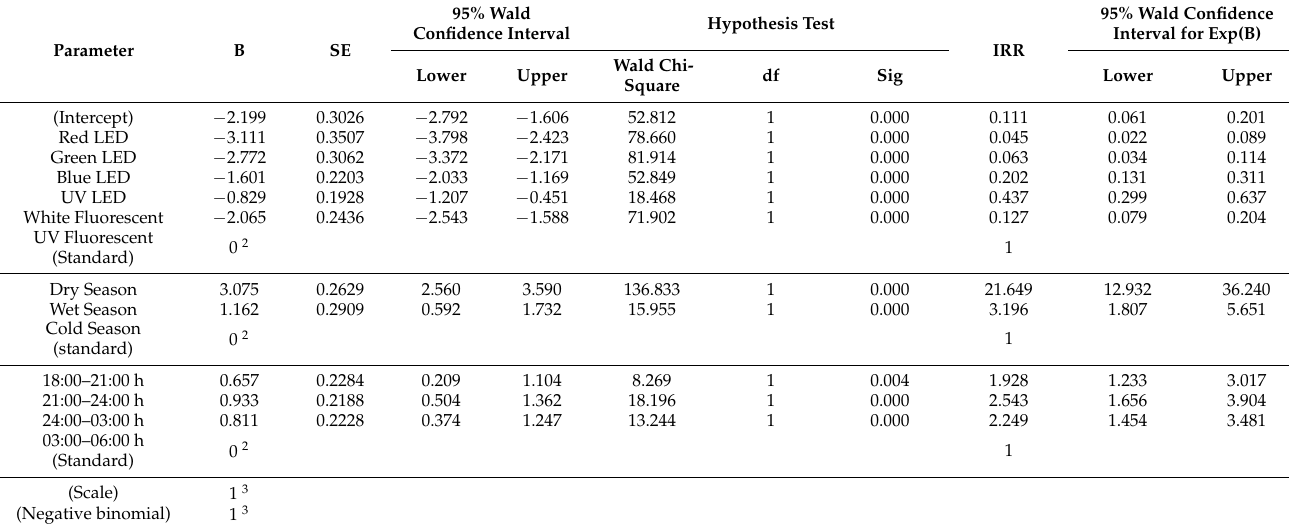
Table 5. Incidence rate ratios of factors influencing the efficacy of light traps for capturing Anopheles mosquitoes. 95% Wald Confidence Parameter B